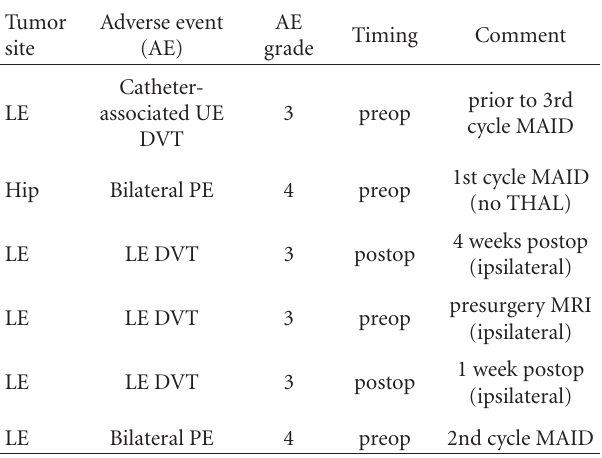
Table 3: Thromboembolic adverse events in 6 patients in cohort A of RTOG